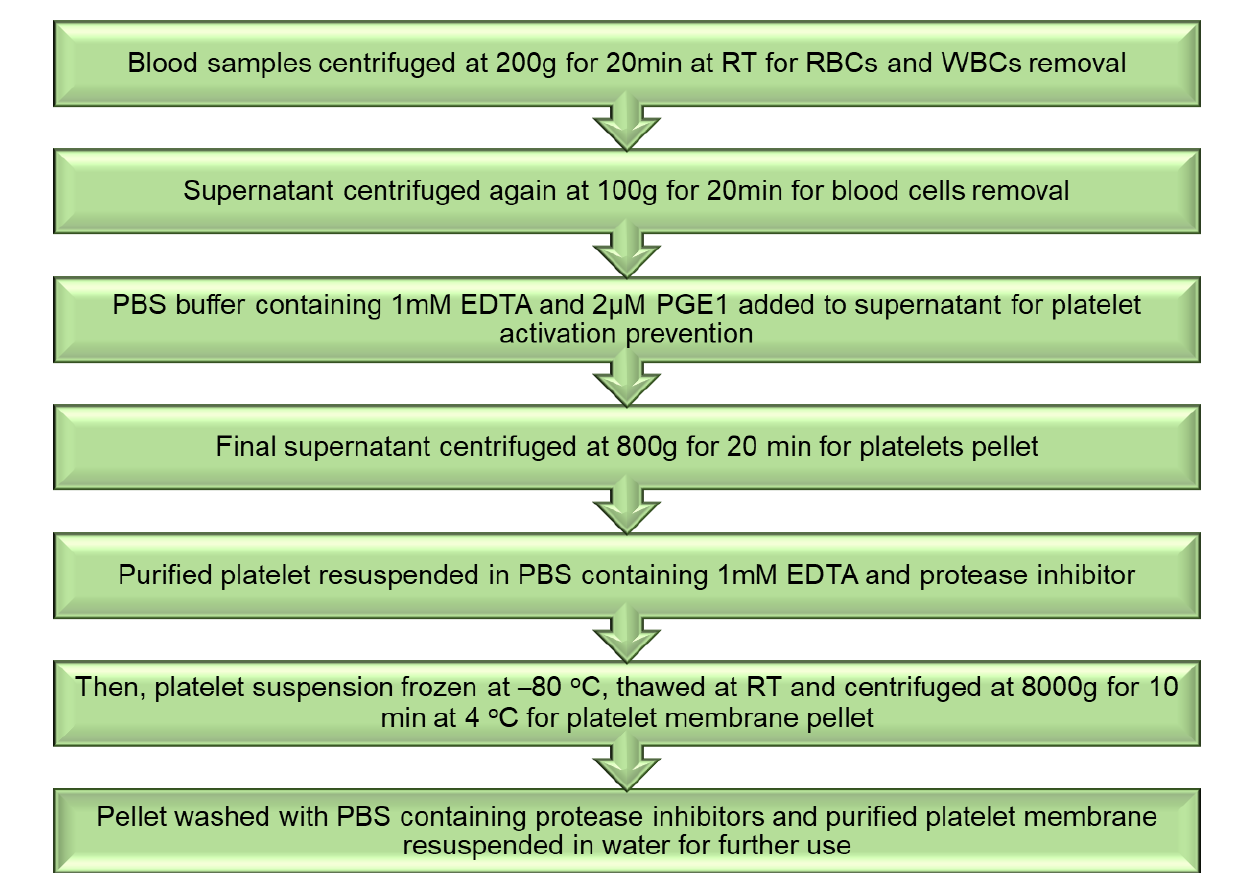
Figure 8. Isolation of platelet and membrane derivation.